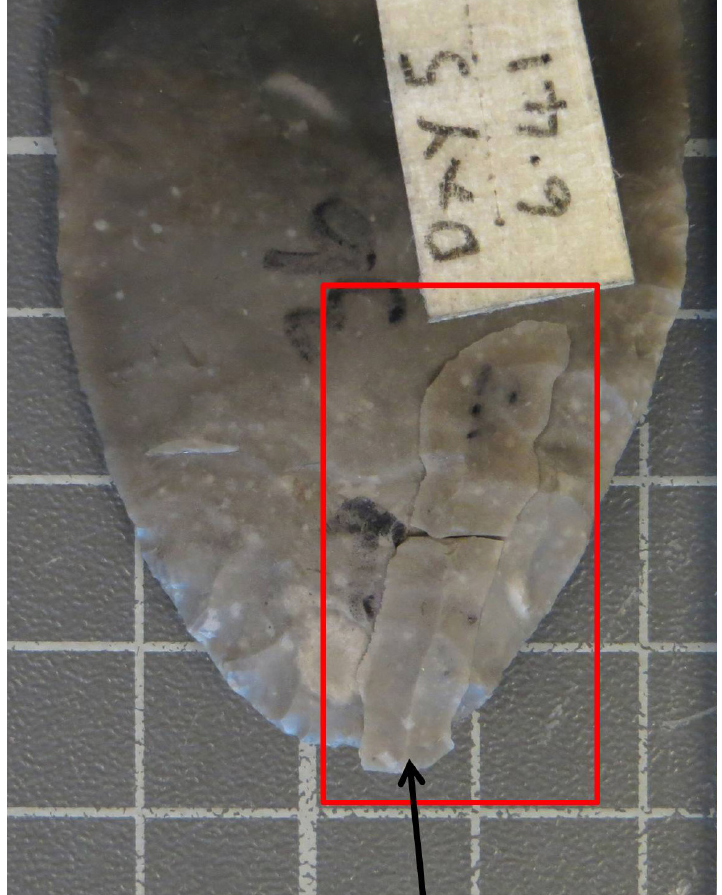
Figure 15. Blade-point 5.19, long flake v3 with the black arrow indicating direction of removal blow (photograph by the author). Gridlines on this image are 10mm